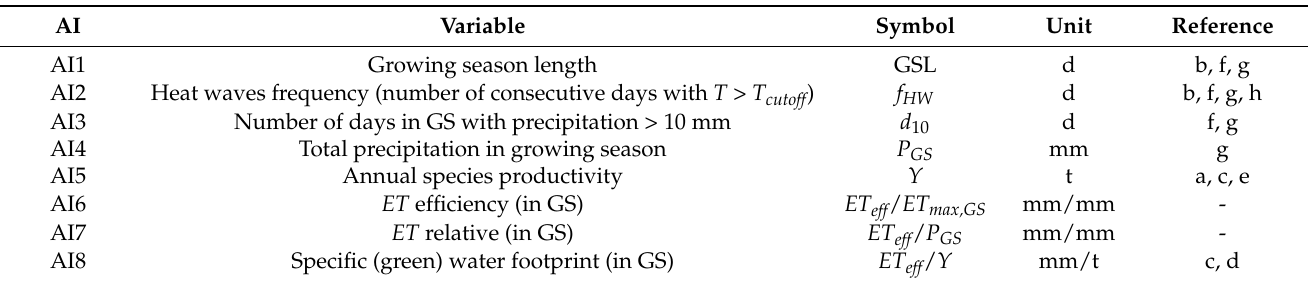
Table 3. Selected agroclimatic indices for the project: indices AI1-AI4 calculated from climate data/projections. Indices AI5-AI8 calculated using Poli-Pasture model. a: [31], b: [39], c: [33], d: [34], e: [35], f: [36], g: [37], h: